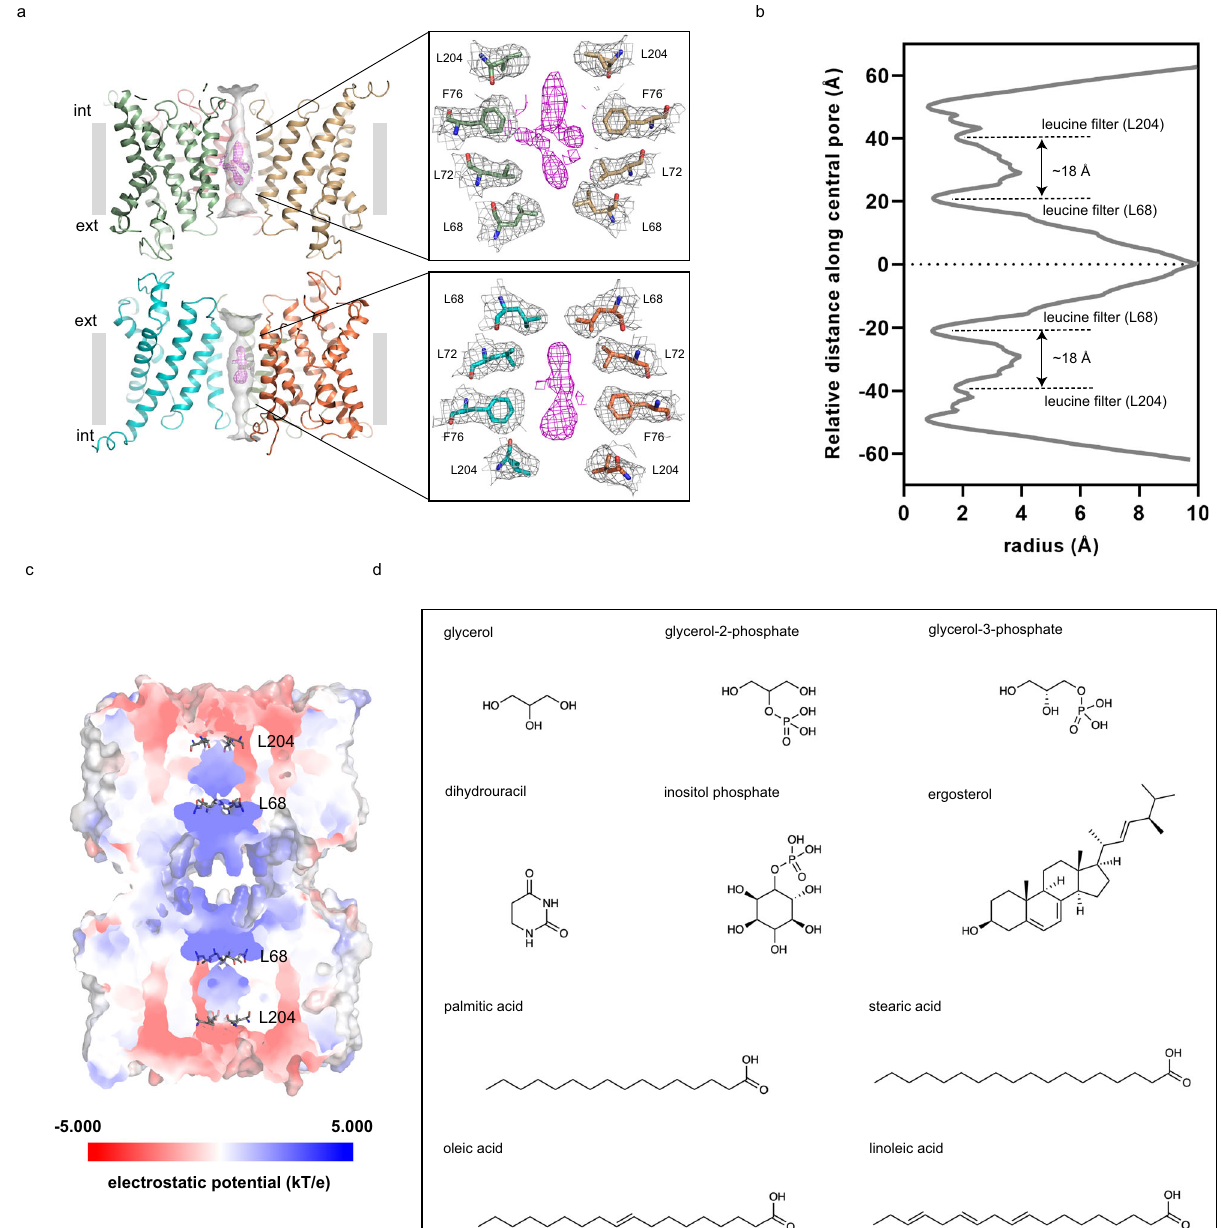
Fig. 6 | The central pore of AQP7 show well de fi ned densities. a Software HOLE analysis of the central pore shown as gray surface, the AQP7 octamer as cartoon, non-proteinous cryo-EM density in the central pore in magenta shown in the same contourlevelasthe poreliningresidues. b Theradiusof thecentralporealongthe pore axis. The central cavity of each tetramer is limited by two quadruplets of